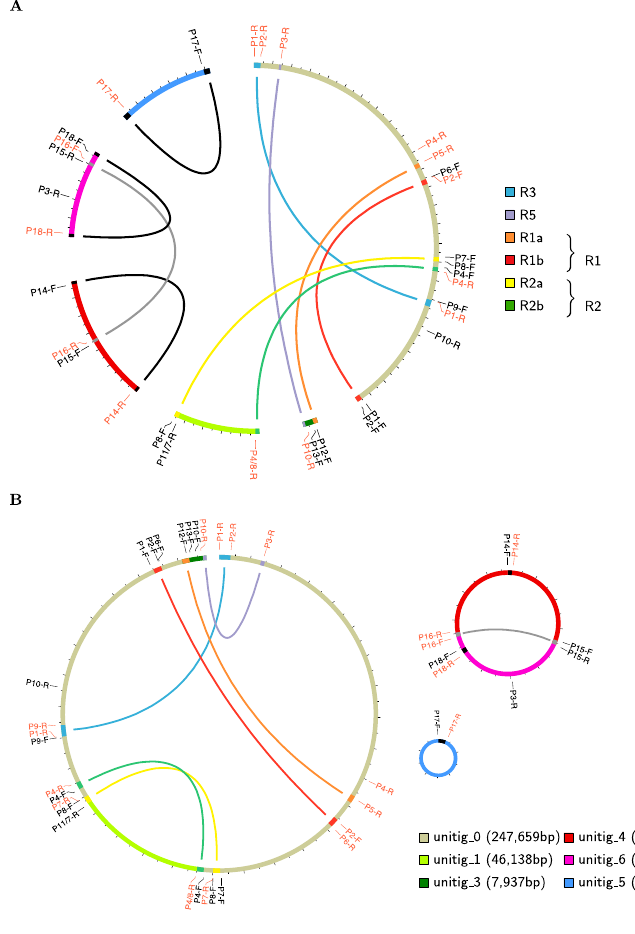
Figure 1. S. tuberosum mitochondrial genome assembly. ( A ) The 6 unitigs output by HGAP for the Cicero mitogenome. Colored blocks on the unitigs show repeats. Labeled ticks give primers positions, with those in black in forward orientation and those in light red in reverse orientation. ( B ) The 3 contigs obtained after PCR validation. Colored blocks on the contigs show repeats. The larger contig could not be circularized.